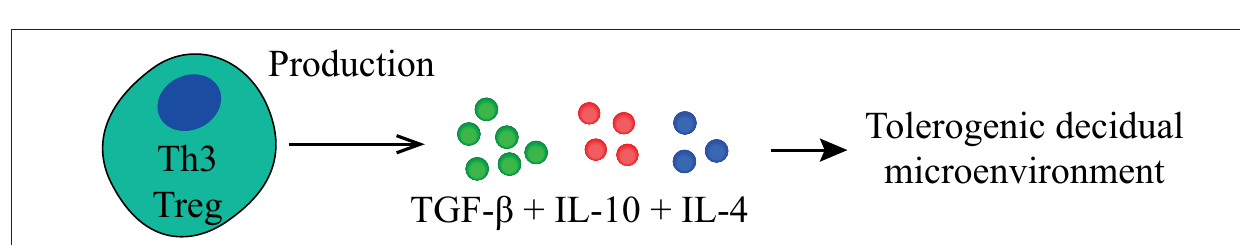
FIGURE 3 | Main tolerogenic mechanisms of the Tr1 regulatory T cell. Tr1 regulatory T cells can in a cell-contact dependent manner lyse APCs via their KIR receptors and disturb the metabolic state of T cells. They produce IL-10 and TGF- β that helps to create a tolerogenic decidual microenvironment. APC, antigen-presenting cell; KIR, killer-cell immunoglobulin-like receptor; IL-10, interleukin-10; TGF- β , transforming growth factor-beta.